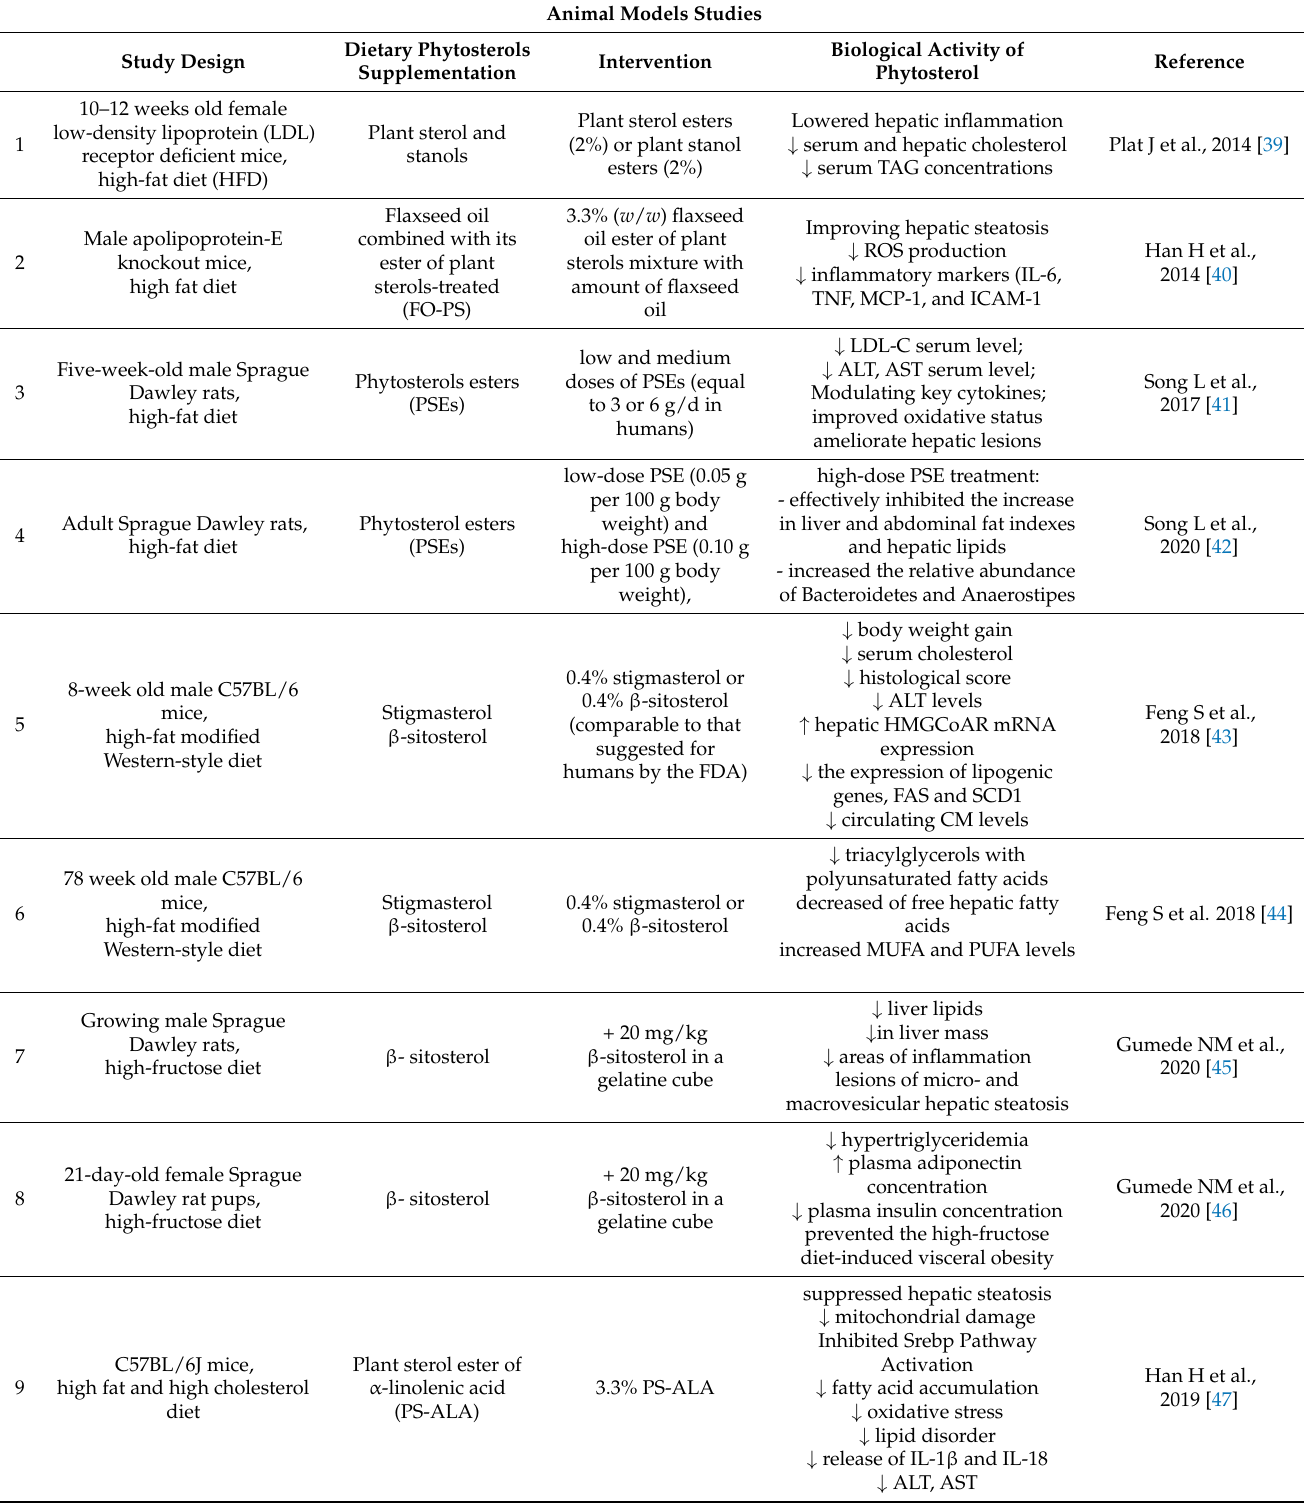
Table 2. Studies on the effects of phytosterols in